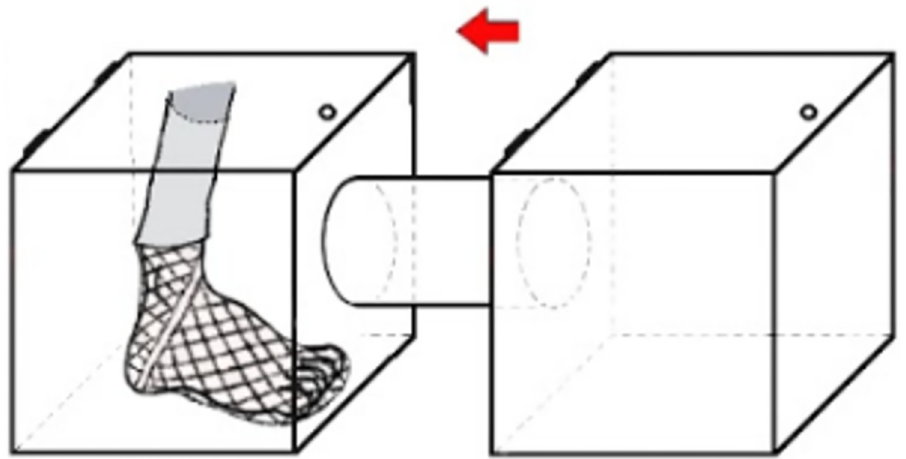
cages are connected with a PLEXIGLAS tube ( l = 30cm, d = 14.6cm). Depending on the chosen treatment for the experiment, the net is either an unwashed PermaNet 2.0 or an untreated net, measuring 25 × 25cm in both cases.